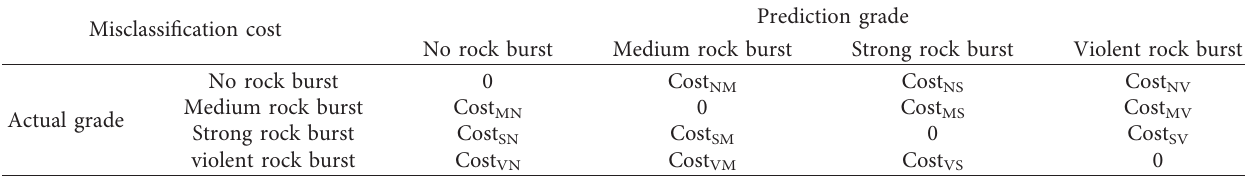
Table 2: Generalized confusion matrix for risk evaluation task of rock burst.